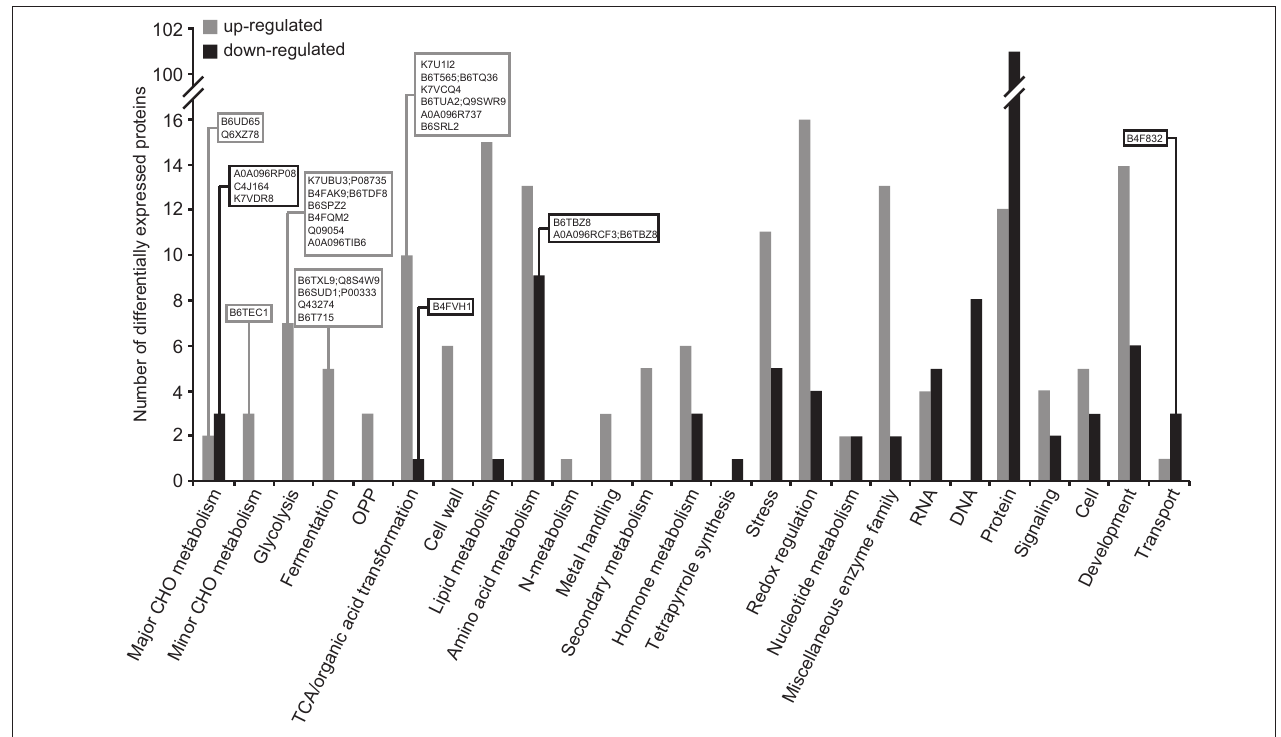
FIGURE 4 | Functional categorization of the proteins differentially expressed in endosperms of Zmbt1-1 and WT seeds. The number of proteins that are up- and down-regulated in Zmbt1-1 endosperms is indicated by gray and black bars, respectively. Proteins are indicated by their accession numbers. Their descriptions are shown in Supplemental Table 1 . Proteins discussed here are